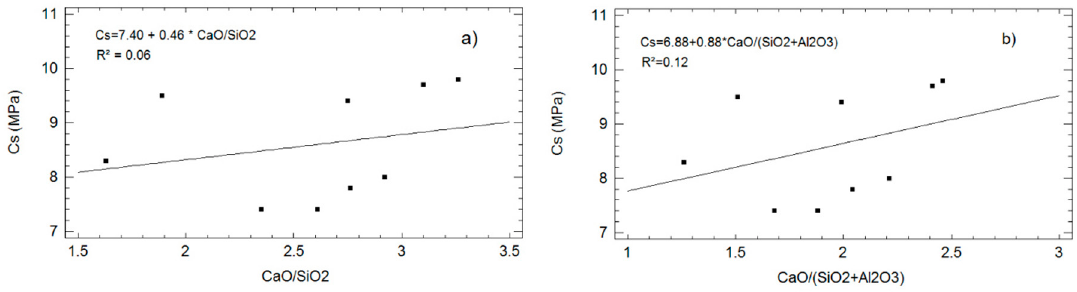
Figure 6. Adjusted models of the relationship between Cs (90 days) and two parameters: ( a ) CaO/SiO 2 ; ( b ) CaO/(SiO 2 + Al 2 O 3 ).